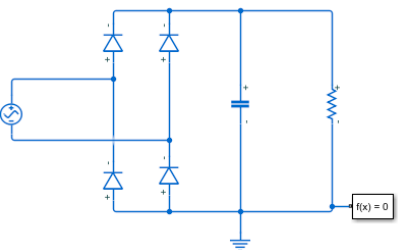
Figure 7. Simulink model of the single-phase rectifier.